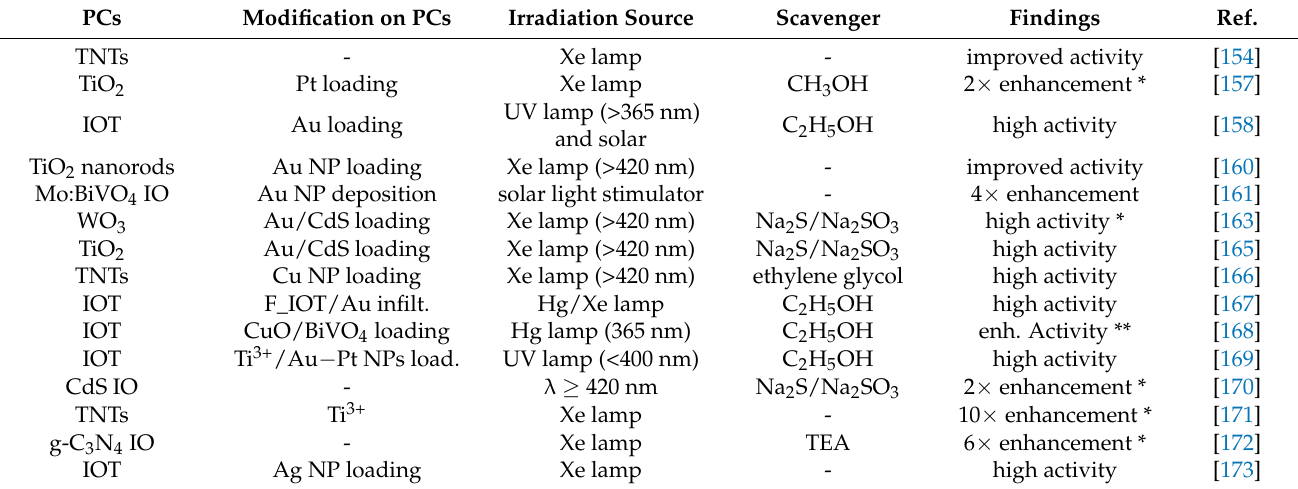
Table 4. Examples of photonic crystals applied for photocatalytic hydrogen